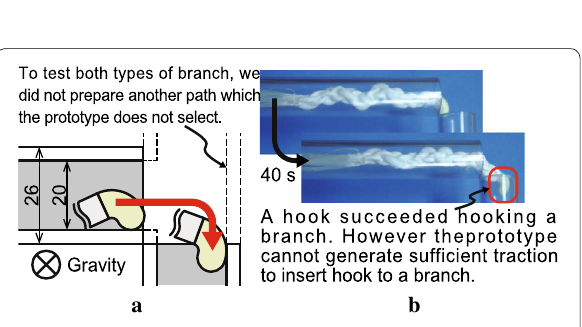
Fig. 17 Hooking experiment in a large pipe in which a prototype cannot move regularly. a The experimental setup. b The